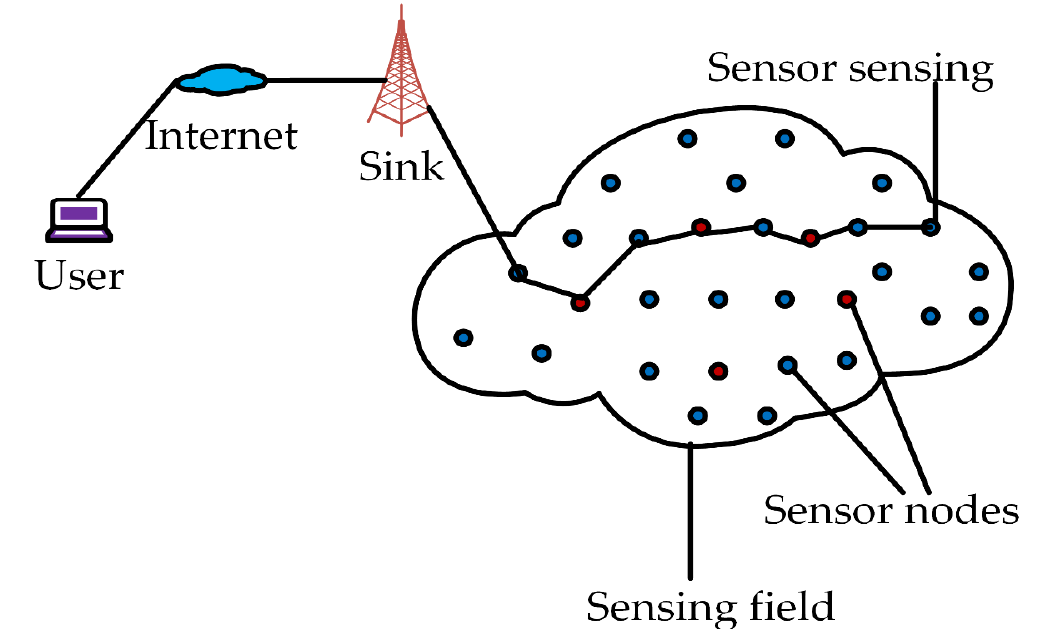
Figure 1. The typical network architecture of sensor nodes in a WSN.